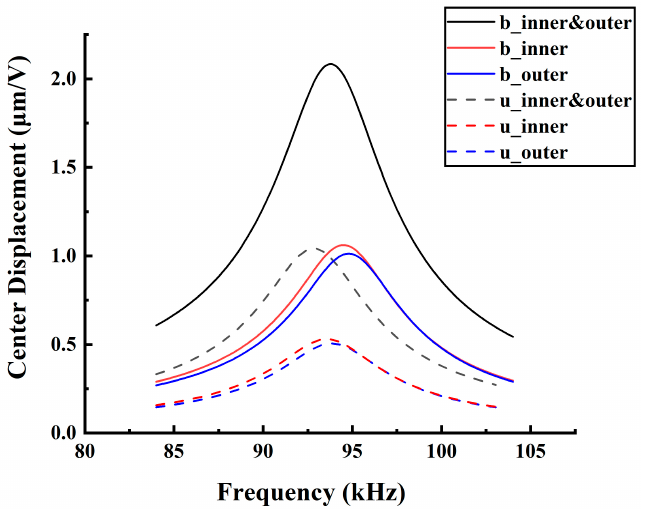
Figure 4. The FEM simulation dynamic sensitivity for the bimorph and unimorph, dual-electrode and single-electrode PMUT.